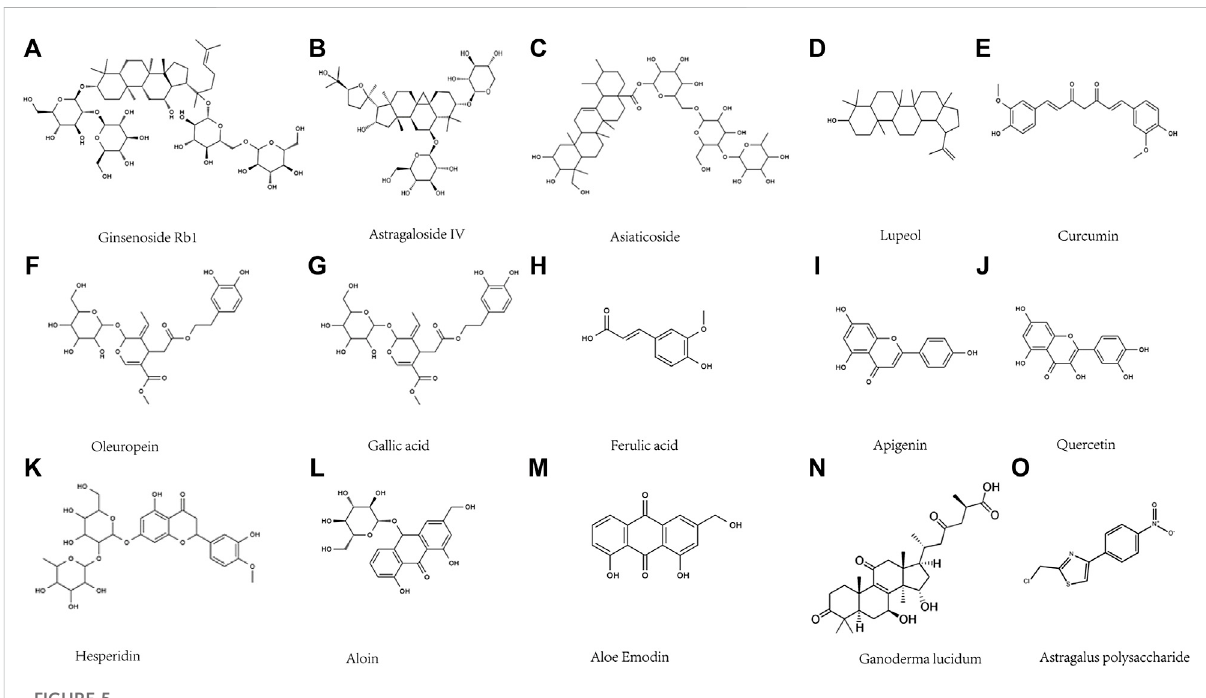
FIGURE 5 Diagram of the chemical formula structure of natural